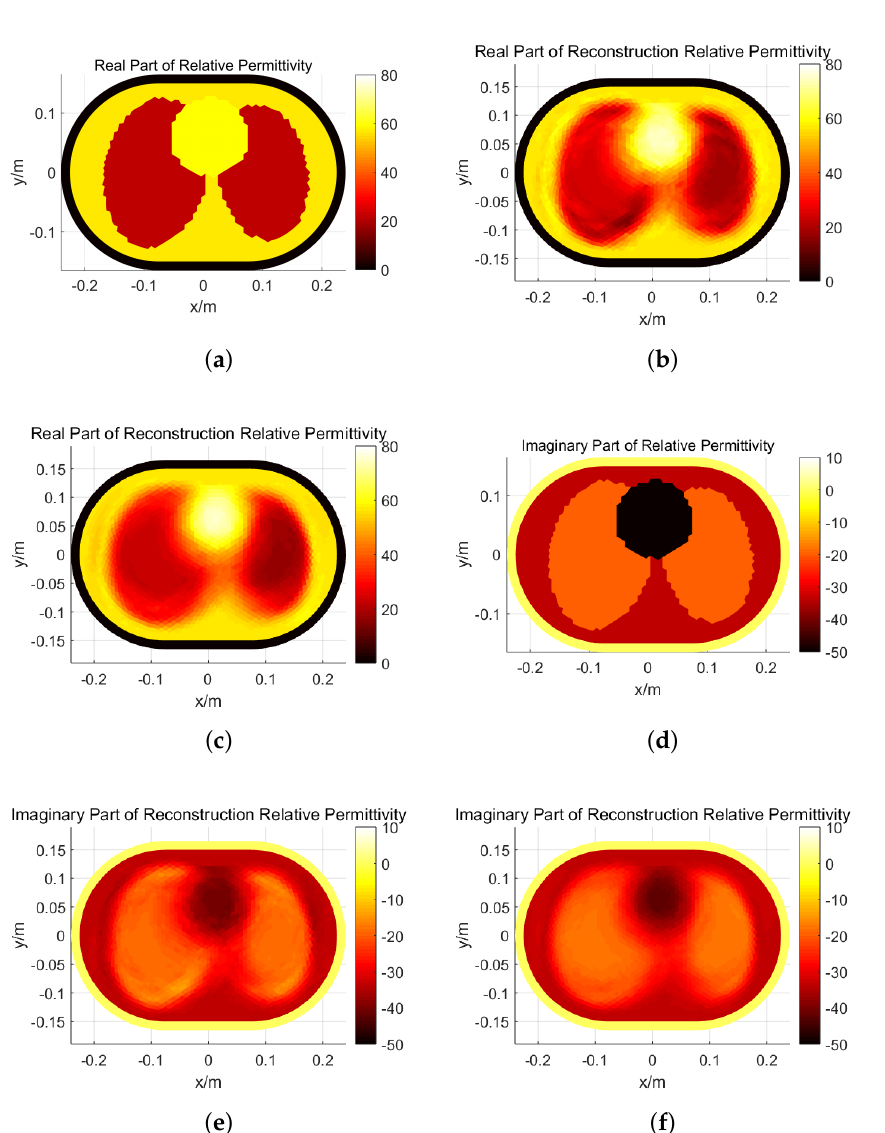
Figure 5. Thorax model for testing at 433MHz: ( a , d ) Real model; ( b , e ) 10-step reconstruction; ( c , f ) One-step reconstruction.